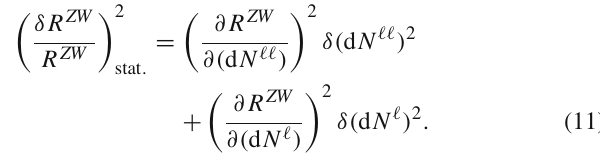
,tothepartonicprediction. DY